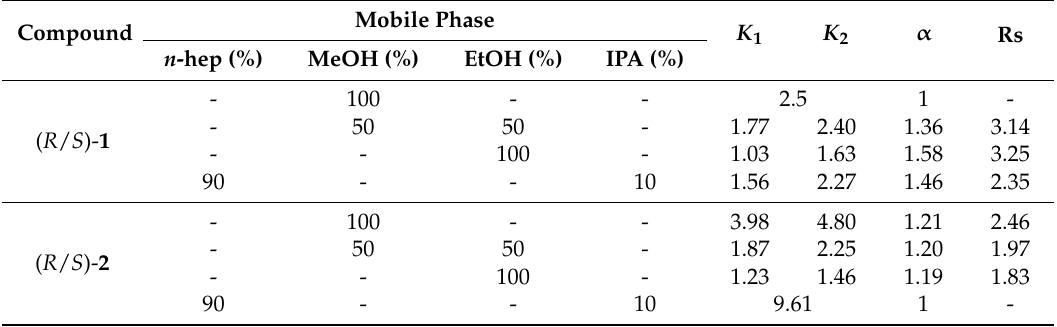
Table 5. Analytical screening on Chiralcel OJ-H with different mobile phases containing 0.1% DEA. Mobile Compound